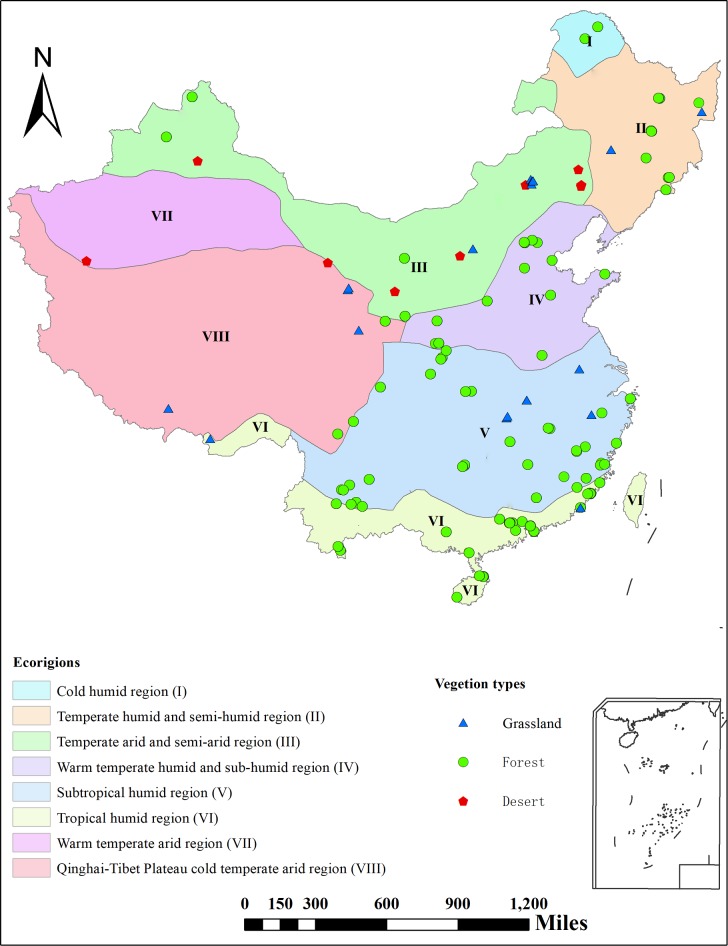
Spatial distribution of sampling sites for the collection of plant caloric values (CAL, KJ g–1) in different vegetation types in China.